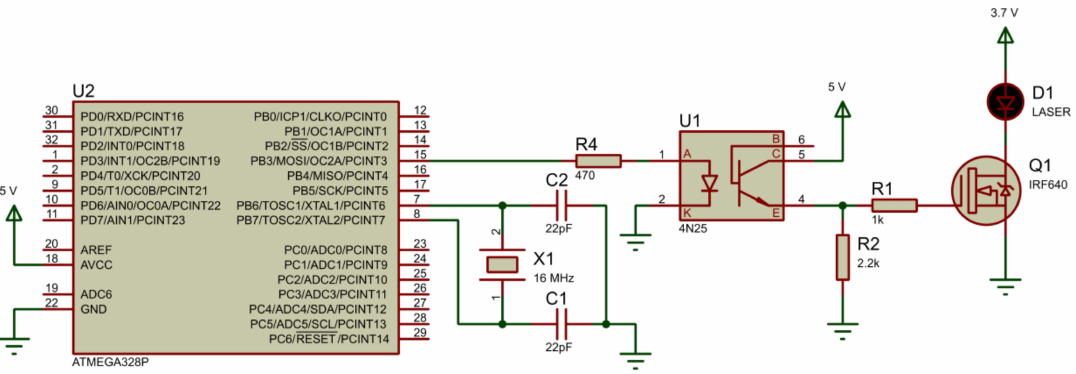
Figure 2. Diagram of the control to generate the conversion signal from a continuous-wave (CW) laser to a pulsed